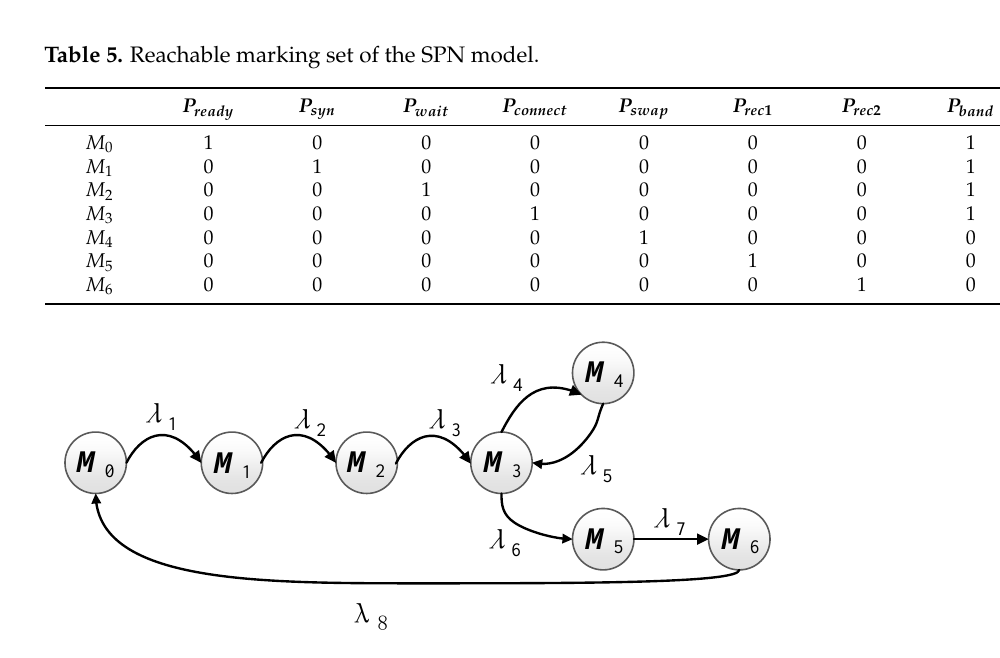
Figure 9. Isomorphic Markov